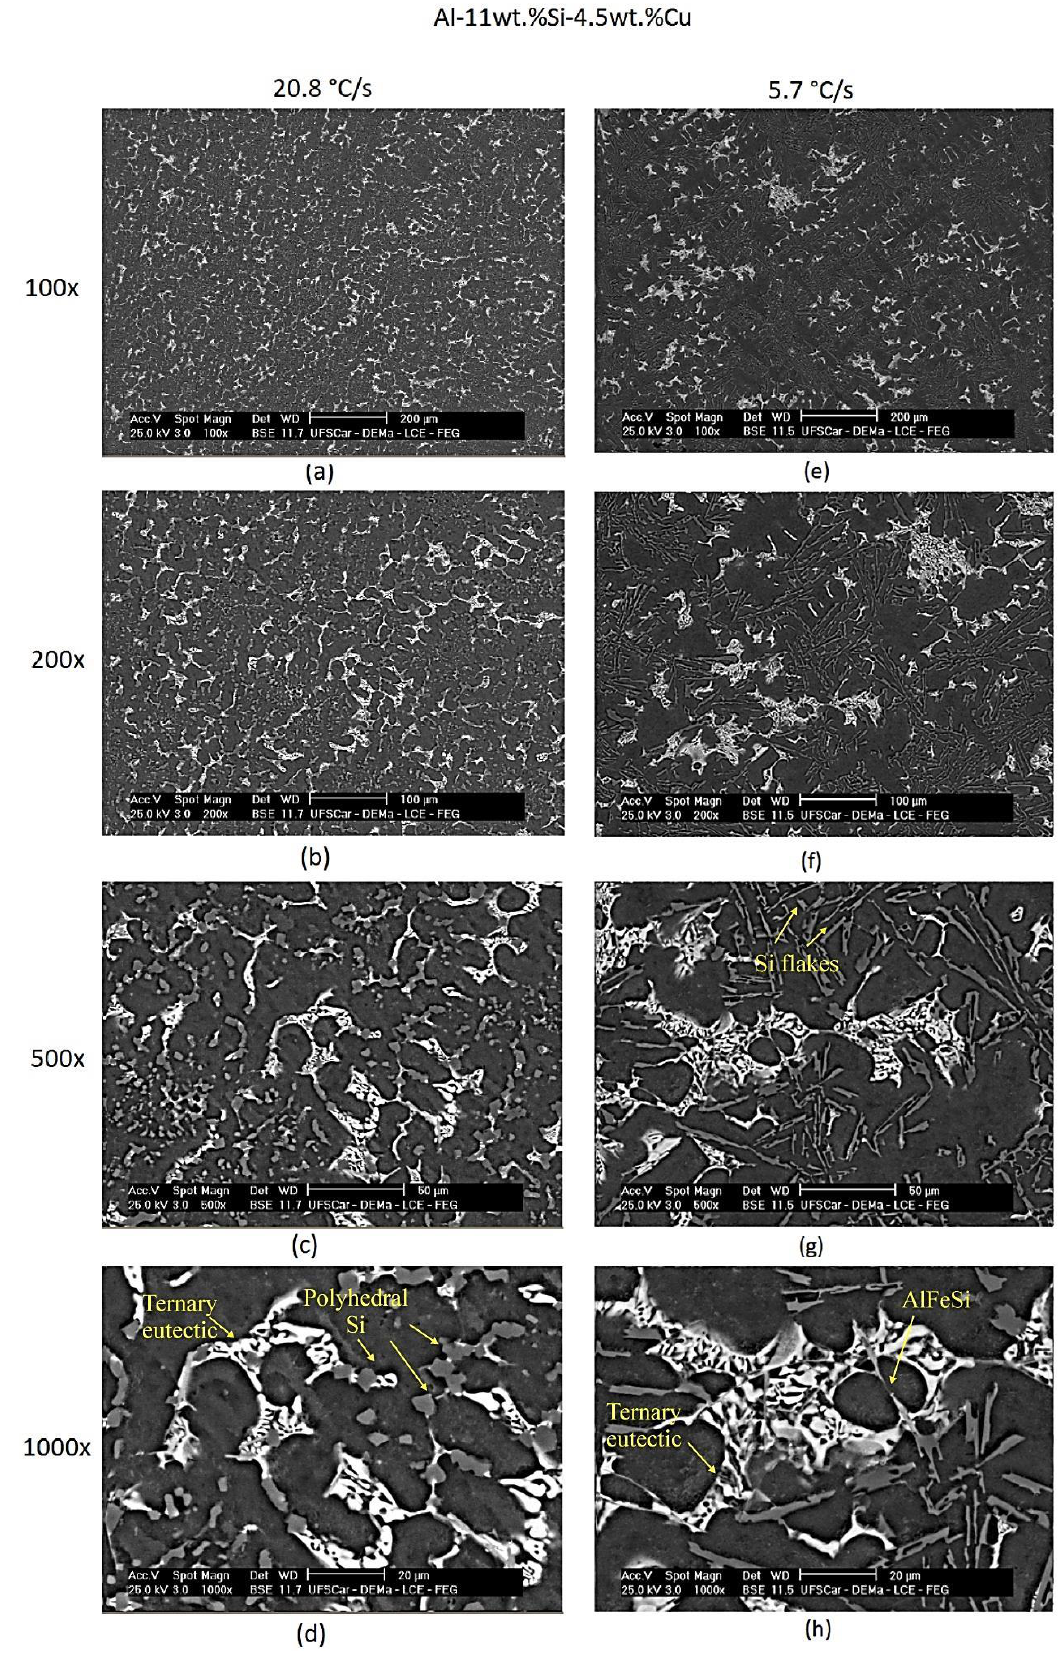
Figure 13. Transverse SEM microstructures related to distinct magnifications and cooling rates (i.e., ( a – d ): 20.8 °C/s and ( e – h ): 5.7 °C/s) during directional solidification of the Al-11wt. %Si-4.5wt. %Cu alloy.